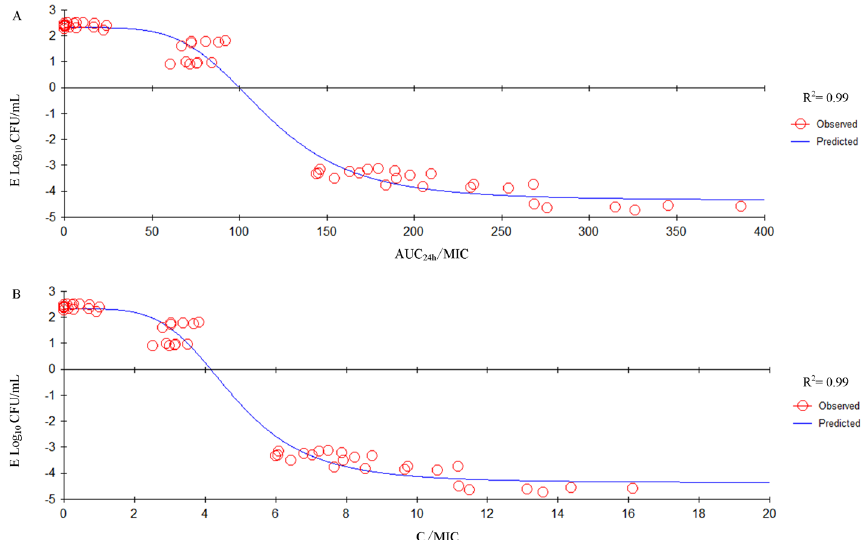
Figure 4. A, B: Plots of antibacterial effect [E, log 10 (CFU/mL)] versus respectively AUC 24h /MIC and C max / MIC of DAN in ileum ultrafiltrate in the ex vivo PK/PD model against E. coli with an inoculum size of 1.49 × 10 6 CFU/mL, based on inhibitory effect sigmoid E max model. Where, R 2 is the correlation coefficient; MIC: minimum inhibitory concentration; AUC 24h : area under the concentration–time curve from 0 to 24 h after DAN administration; C max : the maximum concentration during the dosage interval. The circles represent the values observed for individual animals, and the curve is the line of best fit.